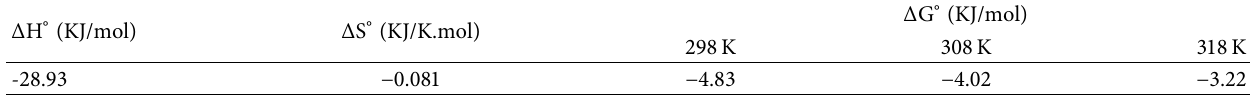
Table 4: Thermodynamic parameters of adsorption of Cr(VI) on the WM.